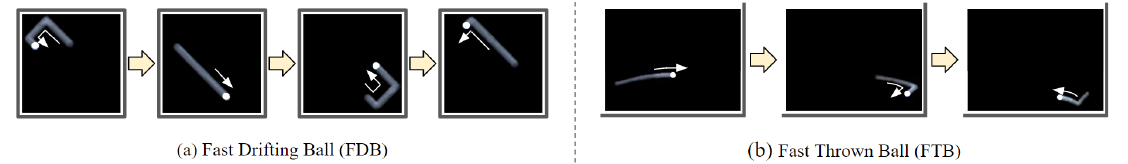
Figure 1. Two physical scenarios used to generate the